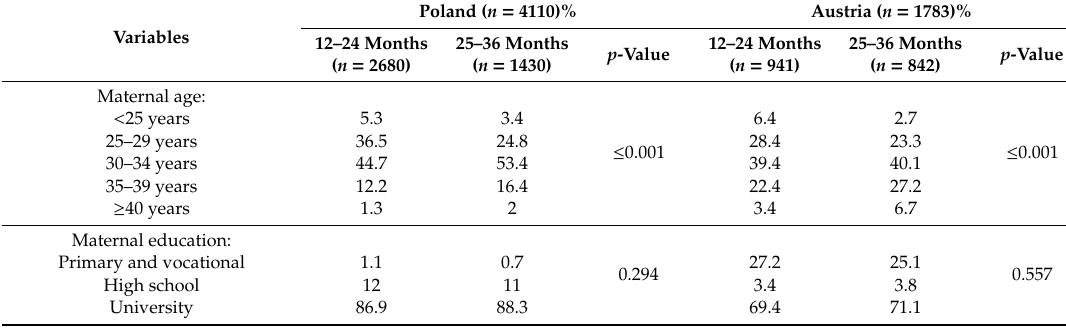
Table 1. Study group characteristics according to sociodemographic factors.